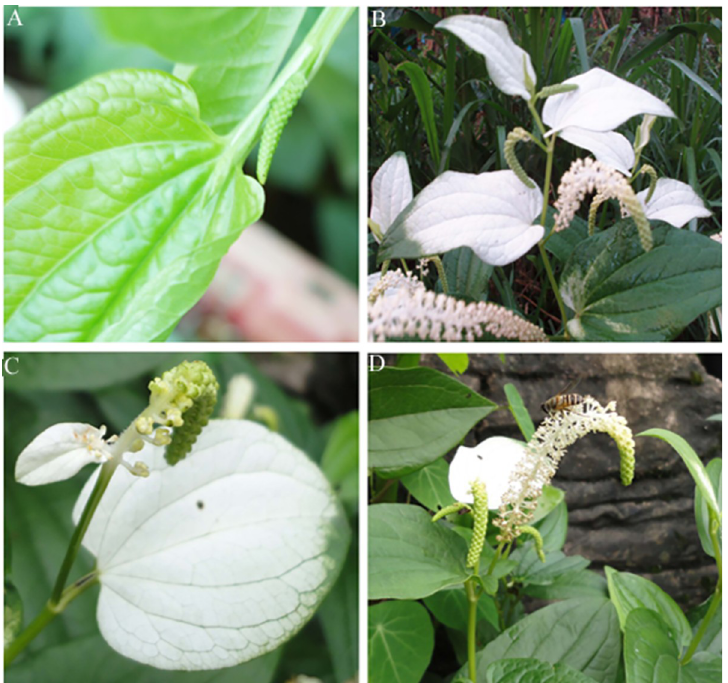
Fig 10. Morphological diversity of the green bracts and white bracts of Saururus chinensis . A) Bracts are initially green. B) Top three bracts are white. C) Occasionally, upper-most bracts are reduced in size and colored white on both adaxial and abaxial surfaces. D) A bee feeding from flowers of S . chinensis